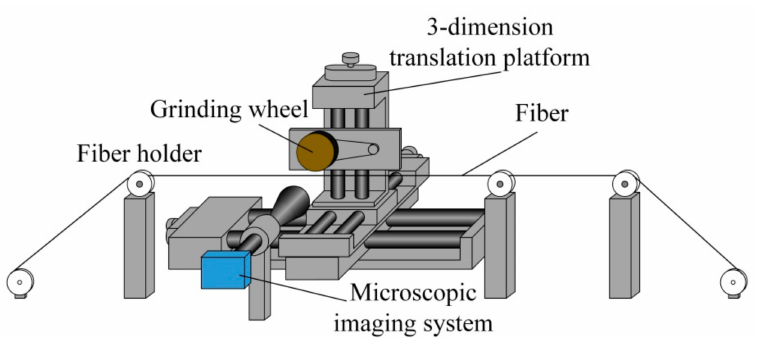
Figure 4. The schematic diagram of the wheel polishing system.